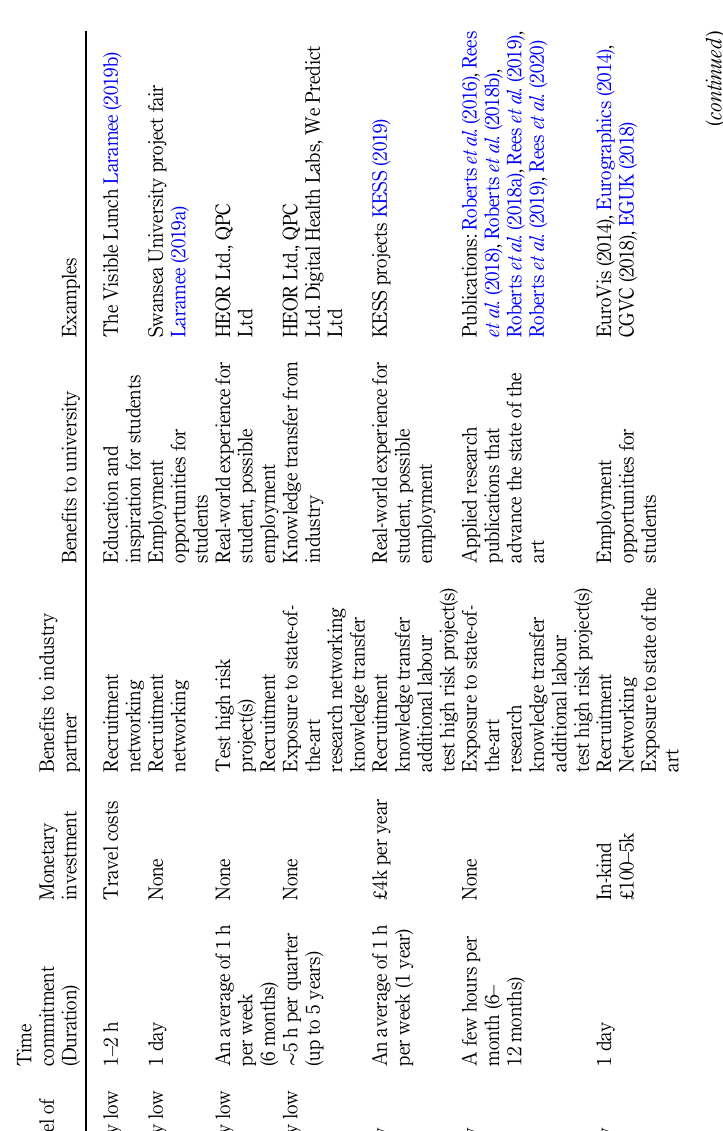
Table 1. A table summarising the engagement possibilities, the associated risks and commitments required and our collaboration